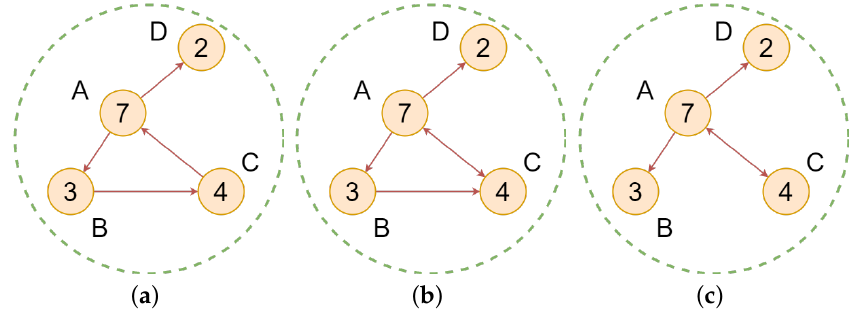
Figure 3. Topology control to regulate energy